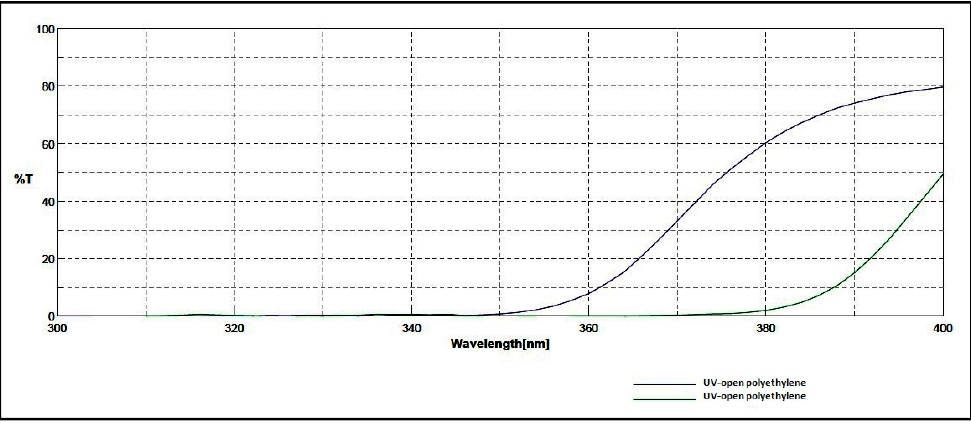
Figure 1. Spectral transmission in UV-A radiation of the UV-open and UV-block